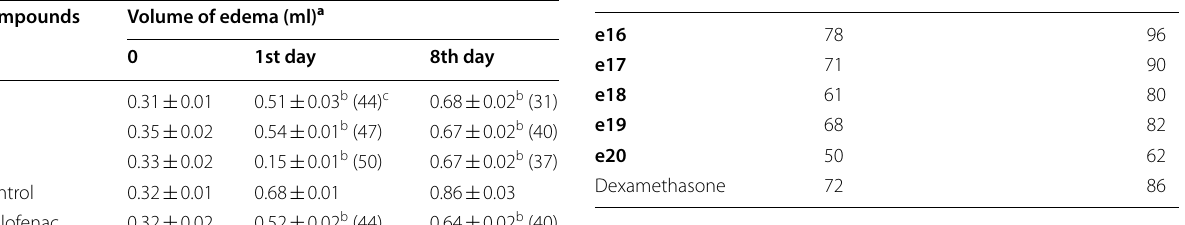
Table 38 Anti-inflammatory activity of compounds (e5– e7) in formal in induced rat paw edema bioassay (sub- acute inflammatory model)